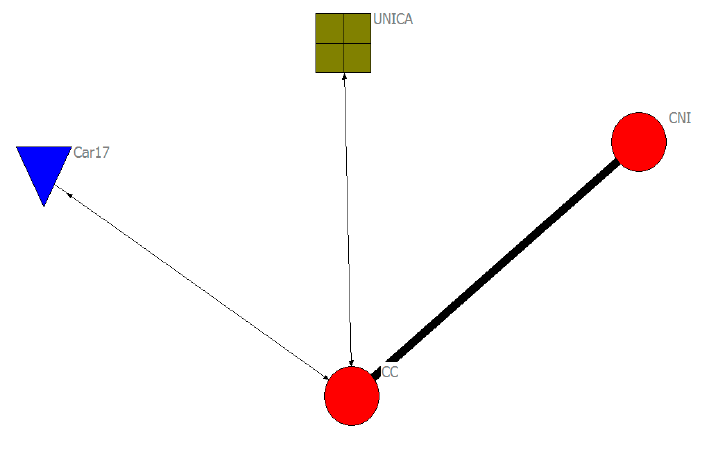
Figure 9. Direct relationships between the Civil House and business association.